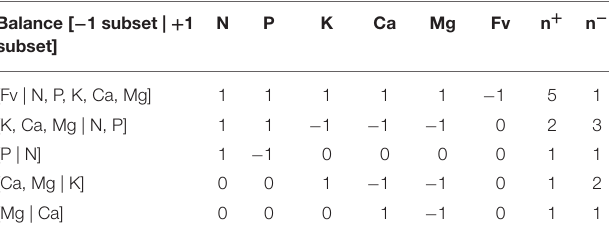
TABLE 1 | Sequential binary partition (SBP) of foliar nutrients of sugar and red maple seedlings based on prior knowledge of nutrient interactions in higher plants (Marschner,